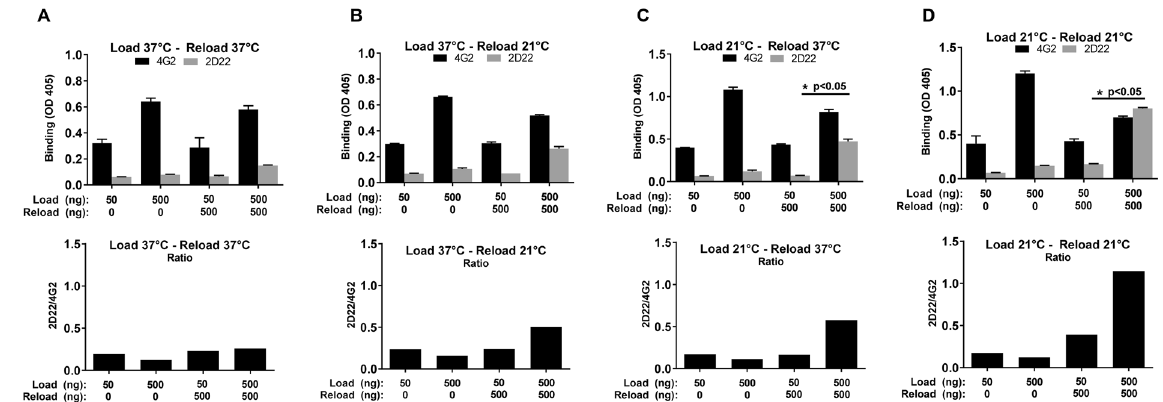
Figure 3. Temperature effects on sRecE dimer formation. Indicated amounts of DENV2 sRecE were loaded and reloaded at different temperatures, resulting in the following temperature regiments: ( A ) Load at 37 °C and reload at 37 °C, ( B ) load at 37 °C and reload at 21 °C, ( C ) load at 21 °C and reload at 37 °C and ( D ) load at 21 °C and reload at 21 °C. Dimer formation was analyzed by 4G2 and 2D22 binding. Groups 500 + 0 and 500 + 500 were statistically compared by student T-test (p <